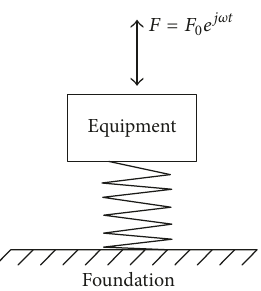
Figure 2: Single-degree-of-freedom vibration isolation